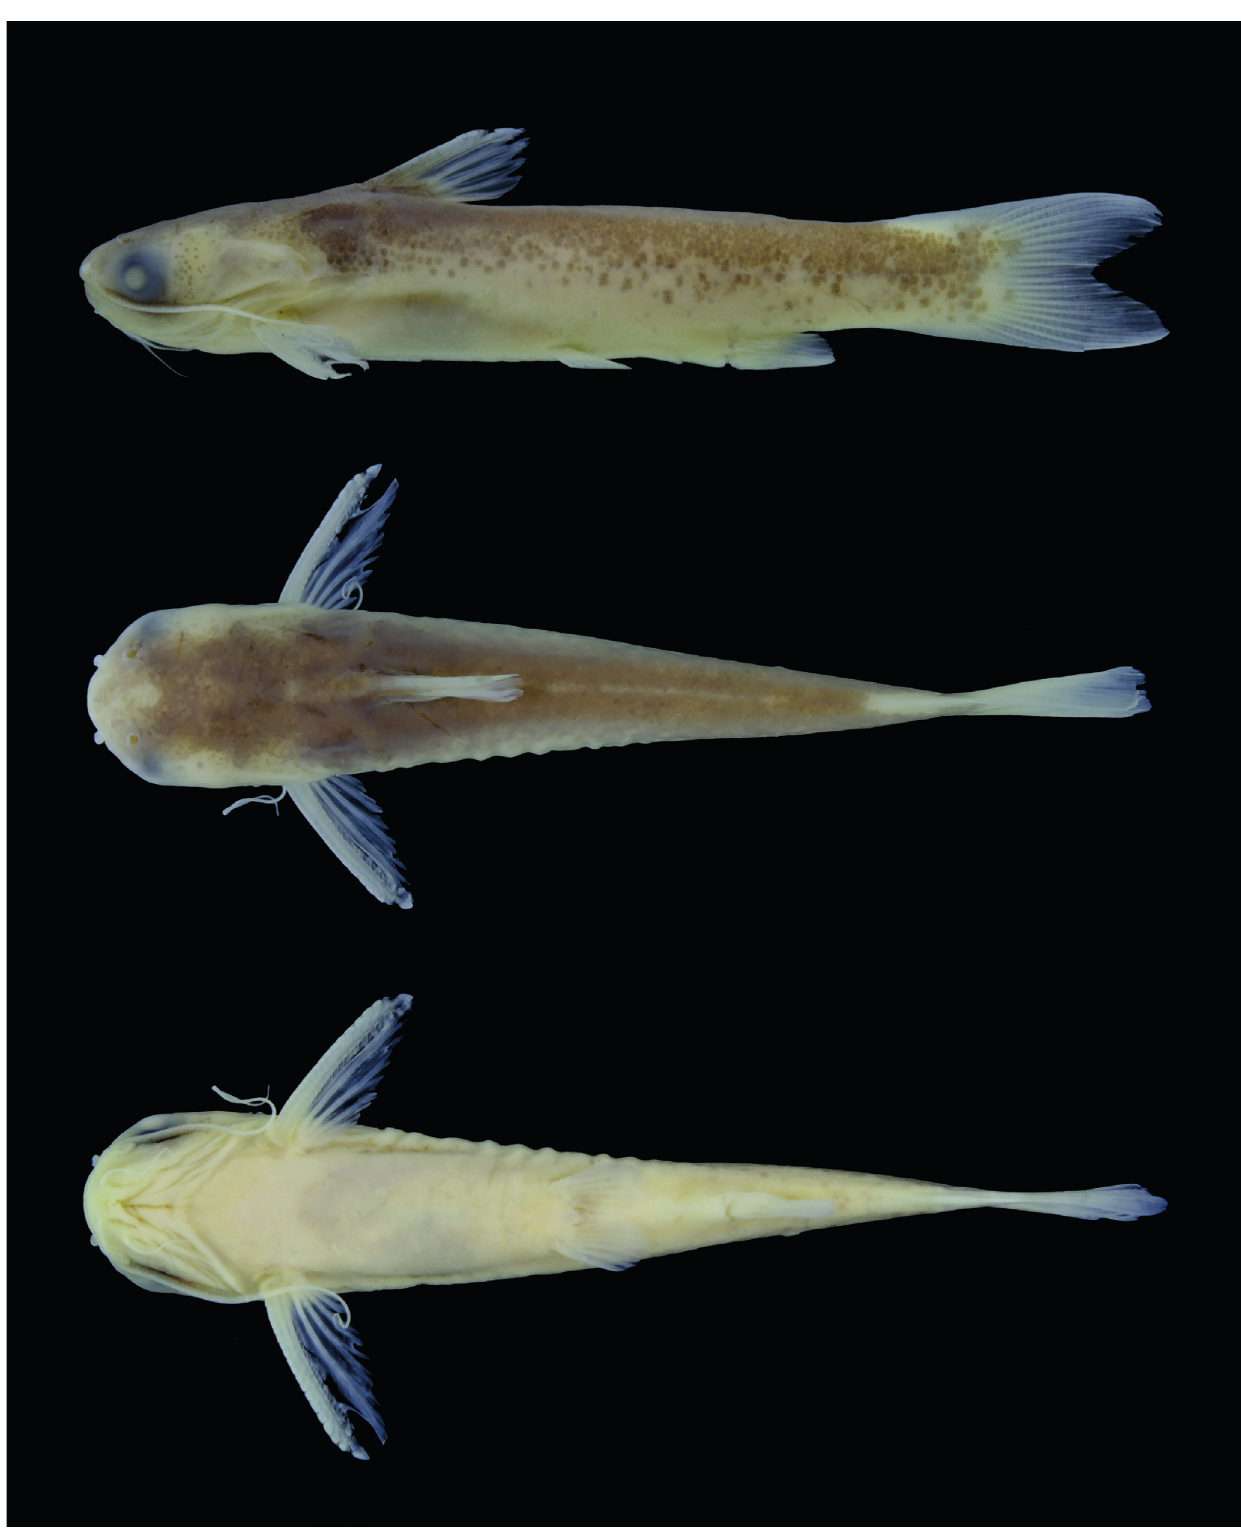
FIGURE 1 | Tatia akroa , lateral, dorsal and ventral views. UFOPA-I 671, holotype, male, 38.8 mm SL, rio Perdida, tributary of rio Sono, rio Tocantins basin, Tocantins State,